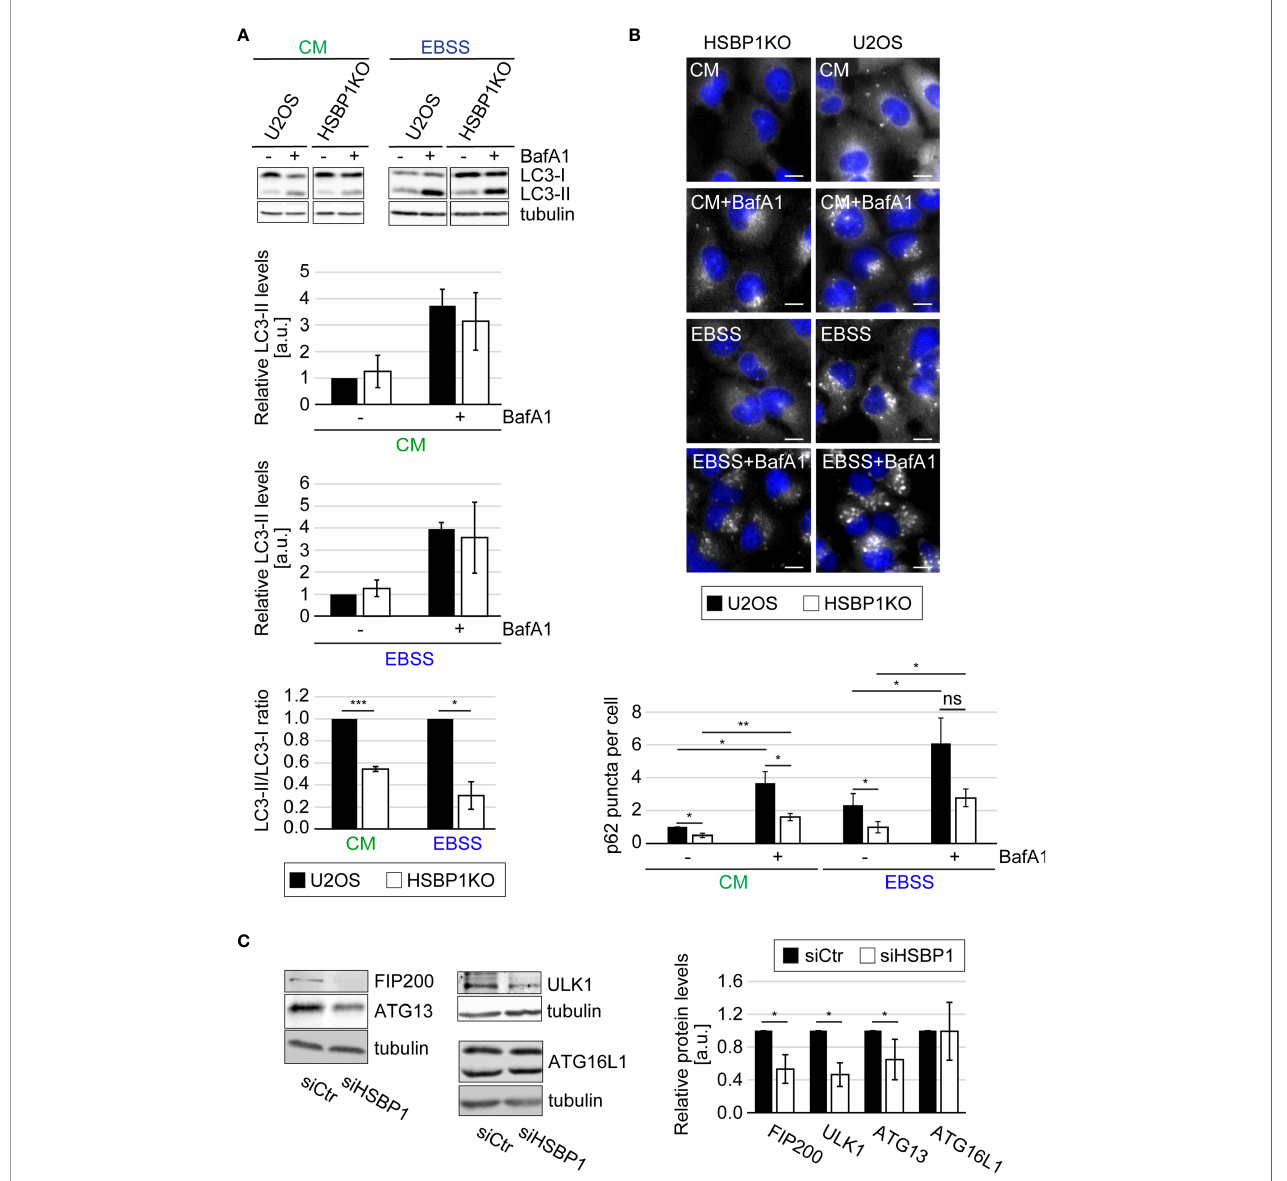
FIGURE 2 | HSBP1 is required for full autophagy induction. (A) U2OS and HSBP1KO cells were maintained in CM or transferred into EBSS medium in the presence (+) or the absence (-) of 200 nM BafA1 for 2 h. Cells were subsequently lysed and WB performed using anti-LC3 and anti-tubulin antibodies. Tubulin served as the loading control. LC3-II WB signals were normalized to tubulin (a.u.) and LC3-II/LC3-I ratios determined. Error bars represent SDs of 3 independent experiments. (B) U2OS and HSBP1KO cells were kept in CM or transferred into EBSS medium in the presence (+) or the absence (-) of 200 nM BafA1 for 2 h. Cells were processed for IF using anti-p62 antibodies. Representative images are shown and the number of p62-positive puncta per cells was quanti fi ed. Scale bars: 10 µm. Error bars represent SDs of 3 independent experiments. (C) U2OS cells were transfected with either siCtr or siHSBP1 for 48 h before to be lysed and carrying WB analyses with antibodies against HSBP1, ATG13, FIP200, ULK1, ATG16L1 and tubulin. Tubulin was used as the loading control. Signal intensities were normalized to tubulin (a.u.). Error bars represent SDs of 3 independent experiments. The symbols *, ** and *** indicate signi fi cant differences of p < 0.05, p < 0.01 and p < 0.001, respectively and ns indicate not signi fi